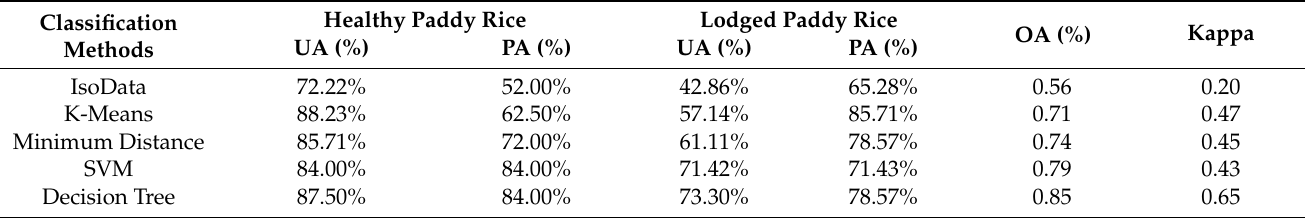
Table 4. Accuracy assessment of four methods: user’s accuracy (UA), producer’s accuracy (PA), overall accuracy (OA) and kappa for the paddy rice-lodging class.